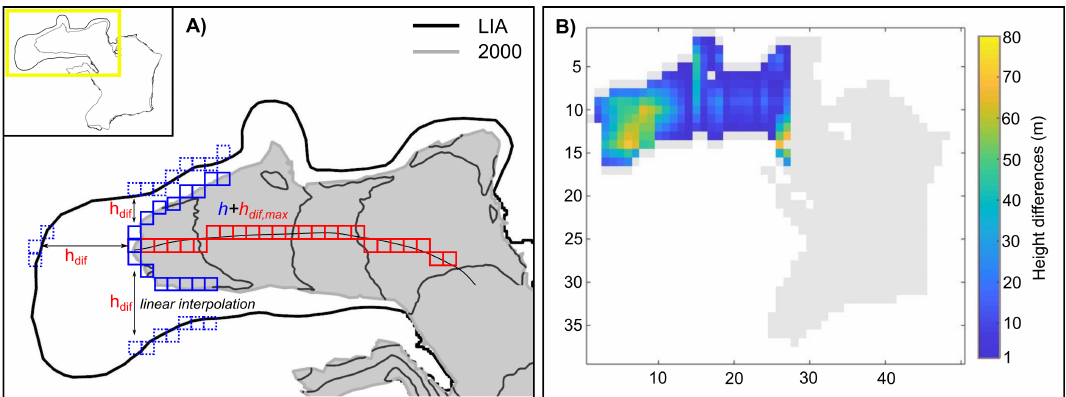
Figure 5. Schematic illustration of Little Ice Age (LIA) height calculations using SRTM data and glacier outlines from 1870 (LIA) [2] and 2000 [30] ( A ), and calculated height differences between the digital elevation model (DEM) adapted to LIA conditions and the initial SRTM-dervied DEM ( B